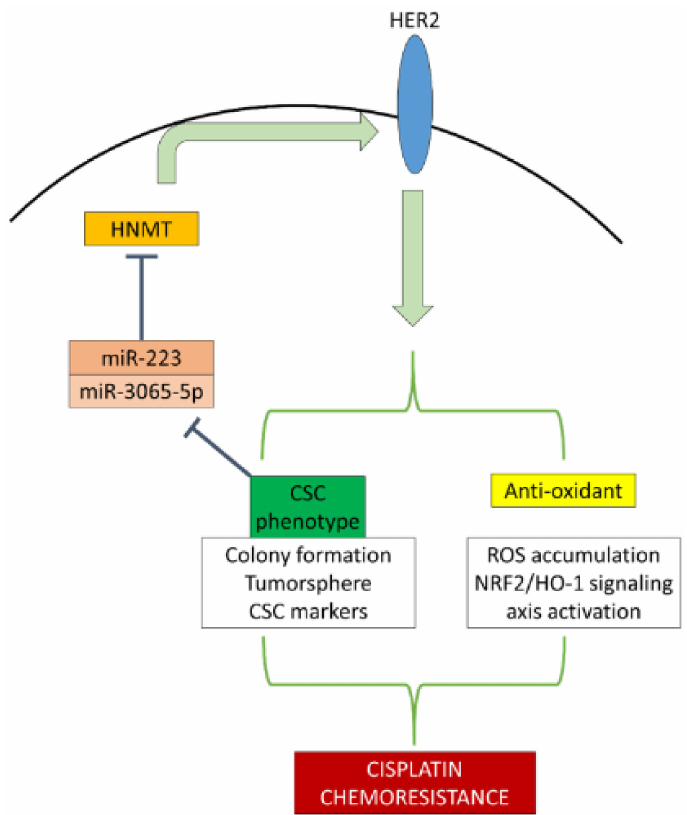
Figure 7. Graphical summary. HNMT interacts with HER2 to induce CSCs phenotype development and enhance NSCLC antioxidant properties, which in turn attenuate miR-223/3065 transcription that loops back to increased HNMT expression. HNMT/HER2-induced CSCs and antioxidant enhancement subsequently resulted in cisplatin chemoresistance in